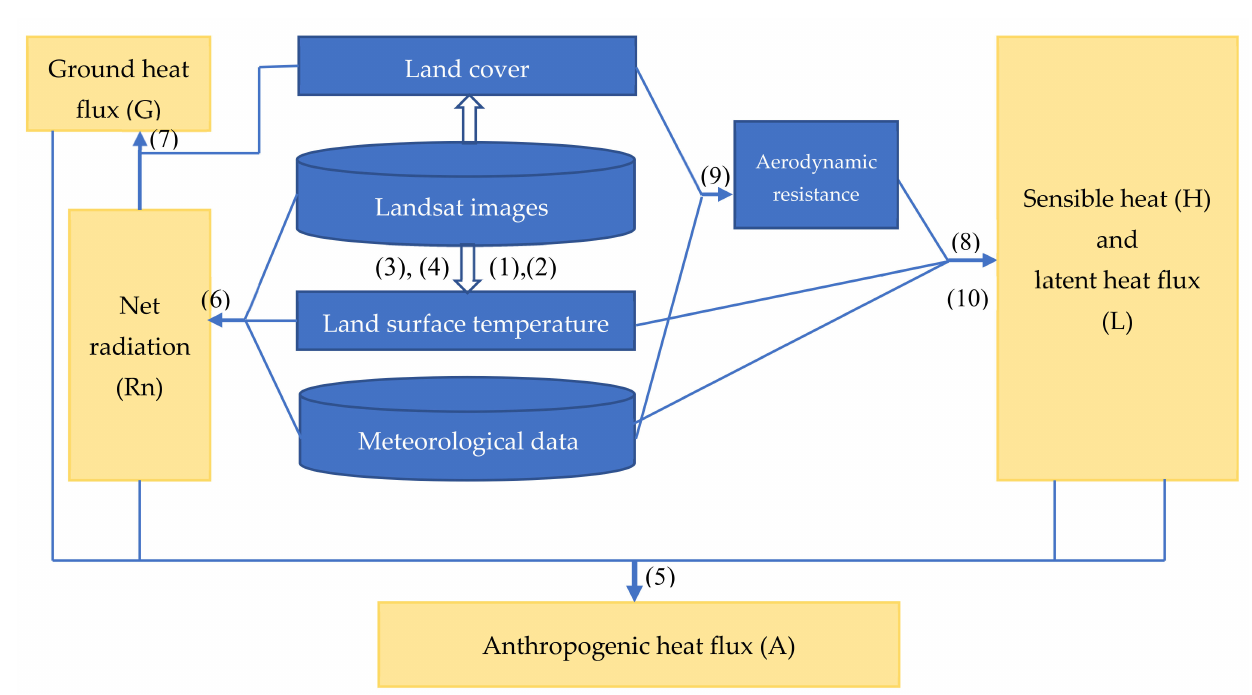
Figure 2. Workflow diagram for the methodology used to estimate anthropogenic heat